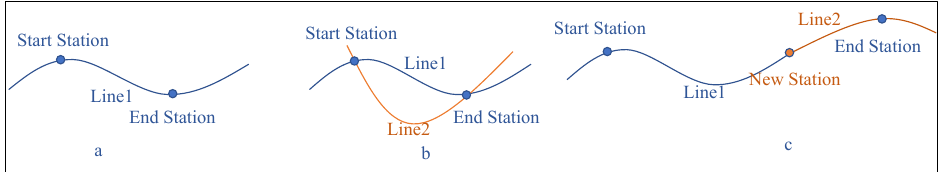
Figure 3. Line Information of the Station: ( a ) Only One Line Connects the Station Node Pair; ( b ) More than One Lines Connects the Station Node Pair; ( c ) No Corresponding Line Passes Between the Station Node Pair.